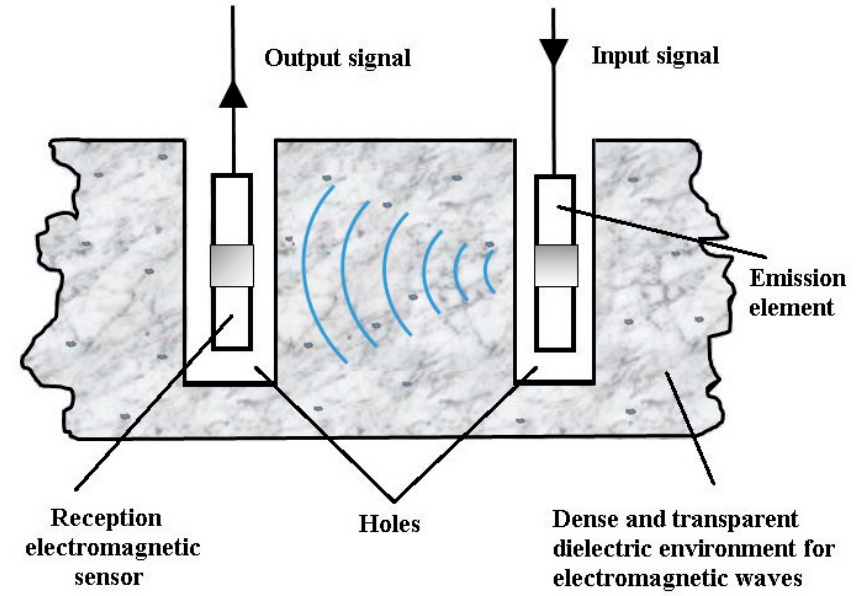
Figure 2. The measurement system inserted into the salt block (horizontal or vertical plane).